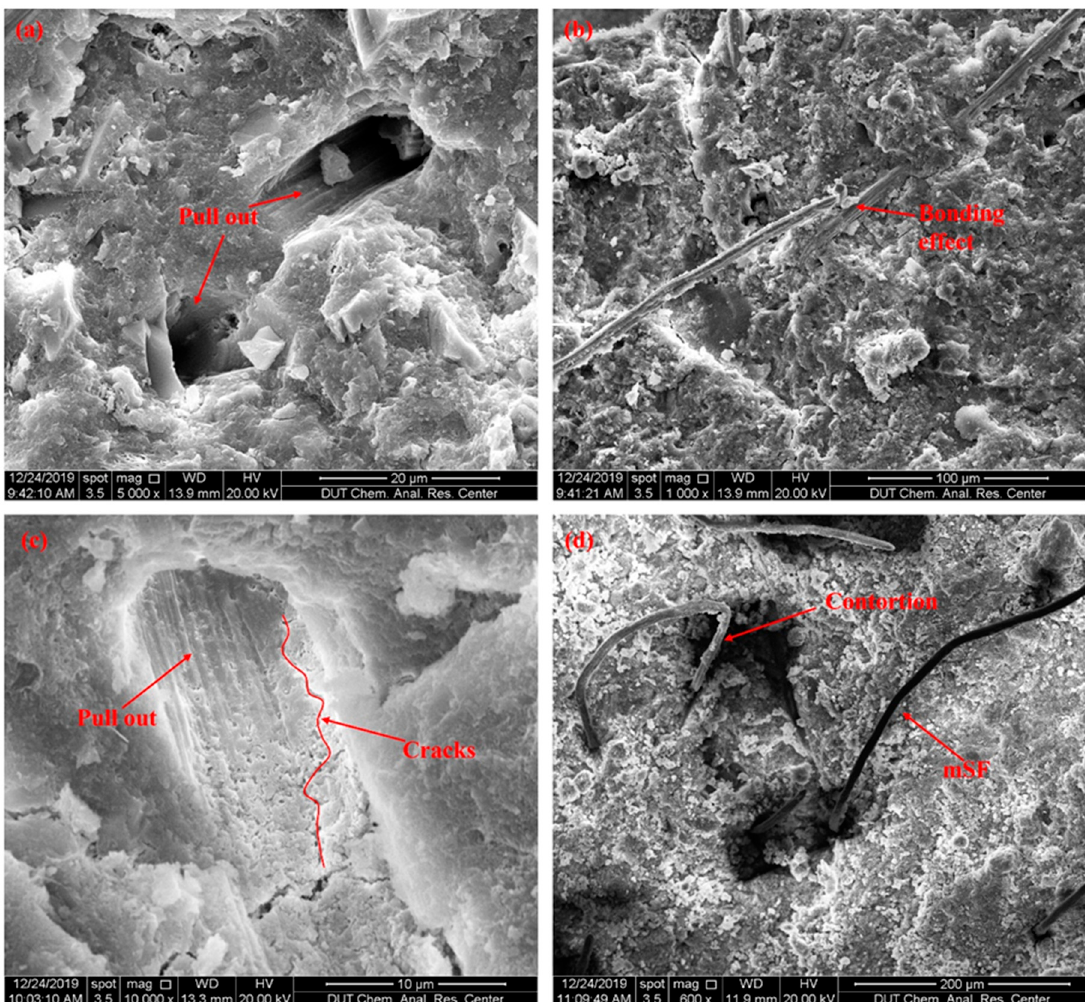
Figure 13. Morphology of mSF in FRC.